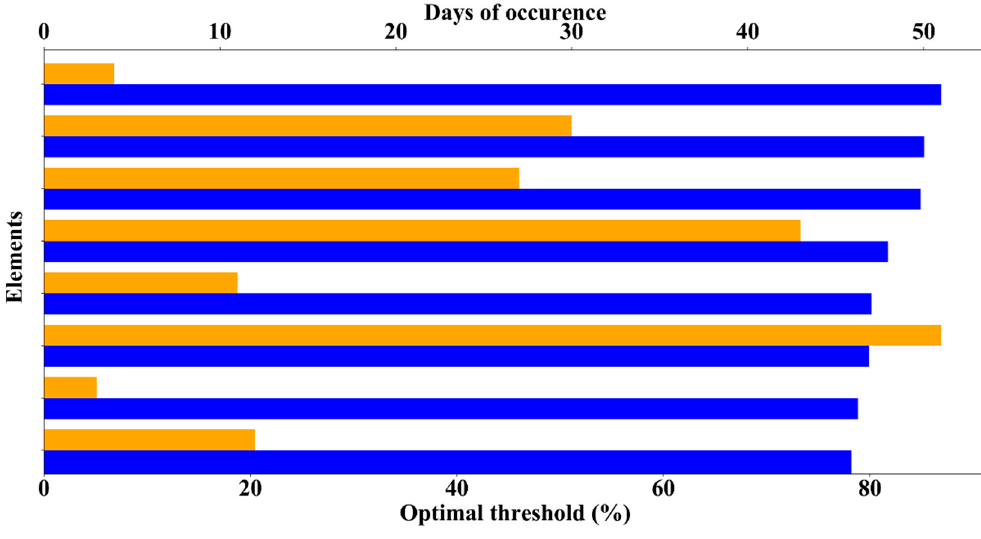
Figure 15. Optimal congestion threshold (in blue) and days of occurrence (in orange) in a set of elements in the case study.